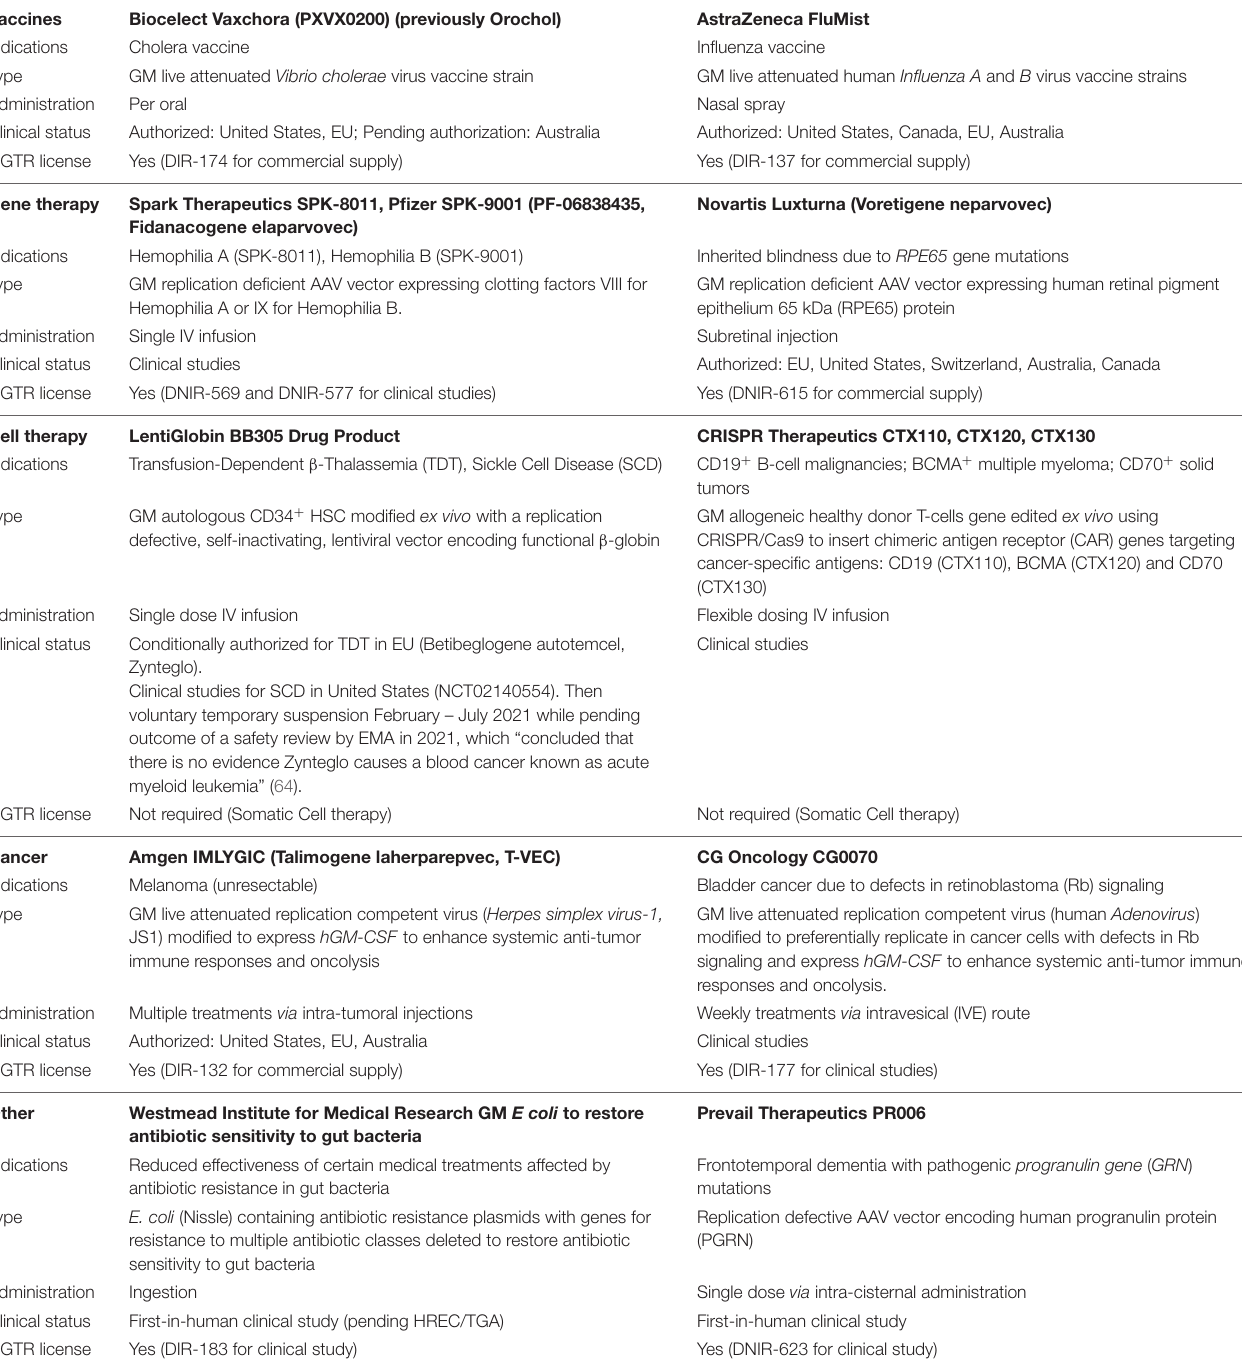
TABLE 2 | Exemplars of gene-based therapies, their regulatory status, and regulatory requirements in Australia. Vaccines Biocelect Vaxchora (PXVX0200) (previously